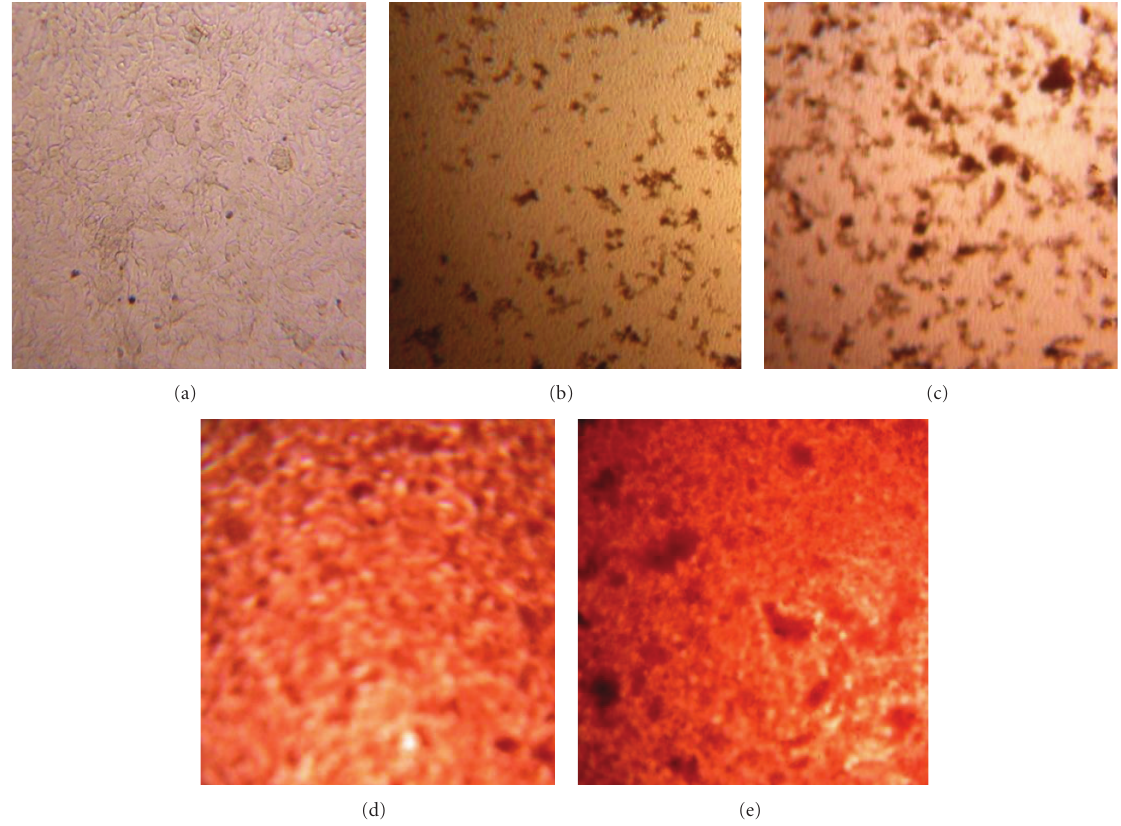
Figure 6: E ff ects of PLA nanocapsule [polyHb-Tyr] on the proliferation of B16F10 melanoma cells. The microscopy images of B16F10 melanoma cells treated with the nanocapsules containing enzyme activities increasing in enzyme activity from (a) to (e): 0, 1, 6, 8, 40, 200